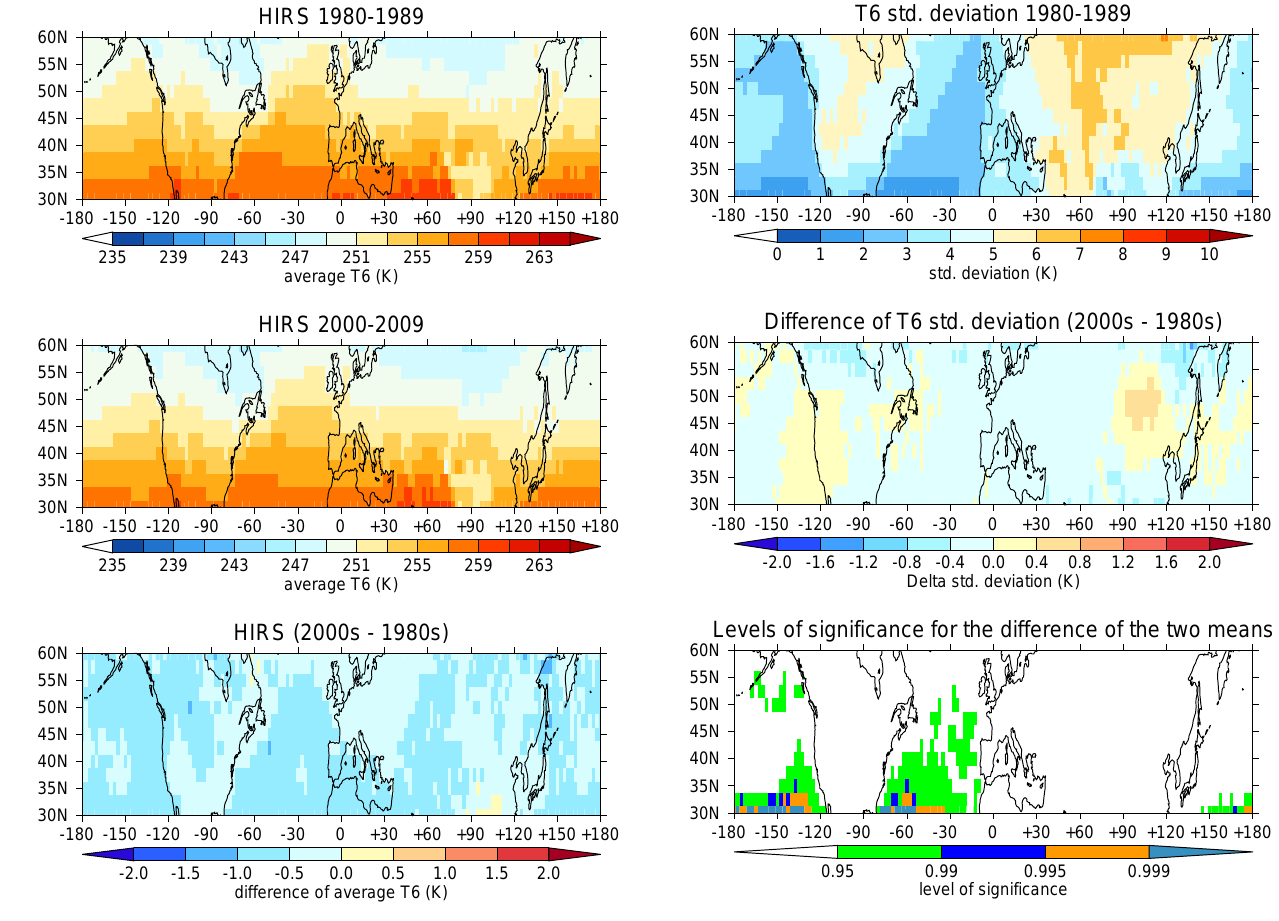
many different satellites employed. Thus, we do not expect such an impact on the interdecadal change of the mean val- ues of the brightness temperatures. The variances could grow if the satellite overpass times would vary more during the 2000s than the 1980s. But we see no reason to believe this and the standard deviations shown in Figs. 6 and 8 are